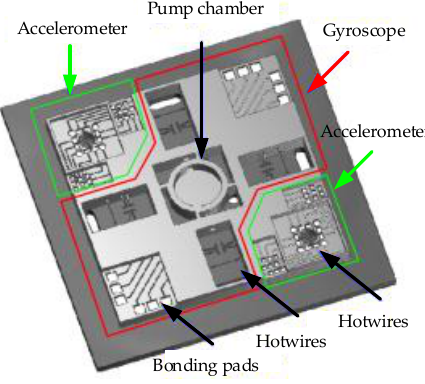
Figure 10. Monolithic jet flow inertial sensor consisting of tri-axis gyroscope and dual-axis accelerometer [82].